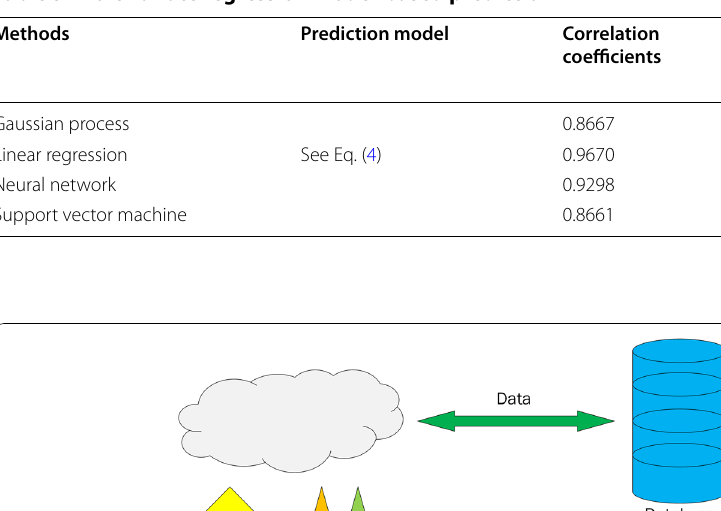
Table 5 Multivariate regression model-based prediction